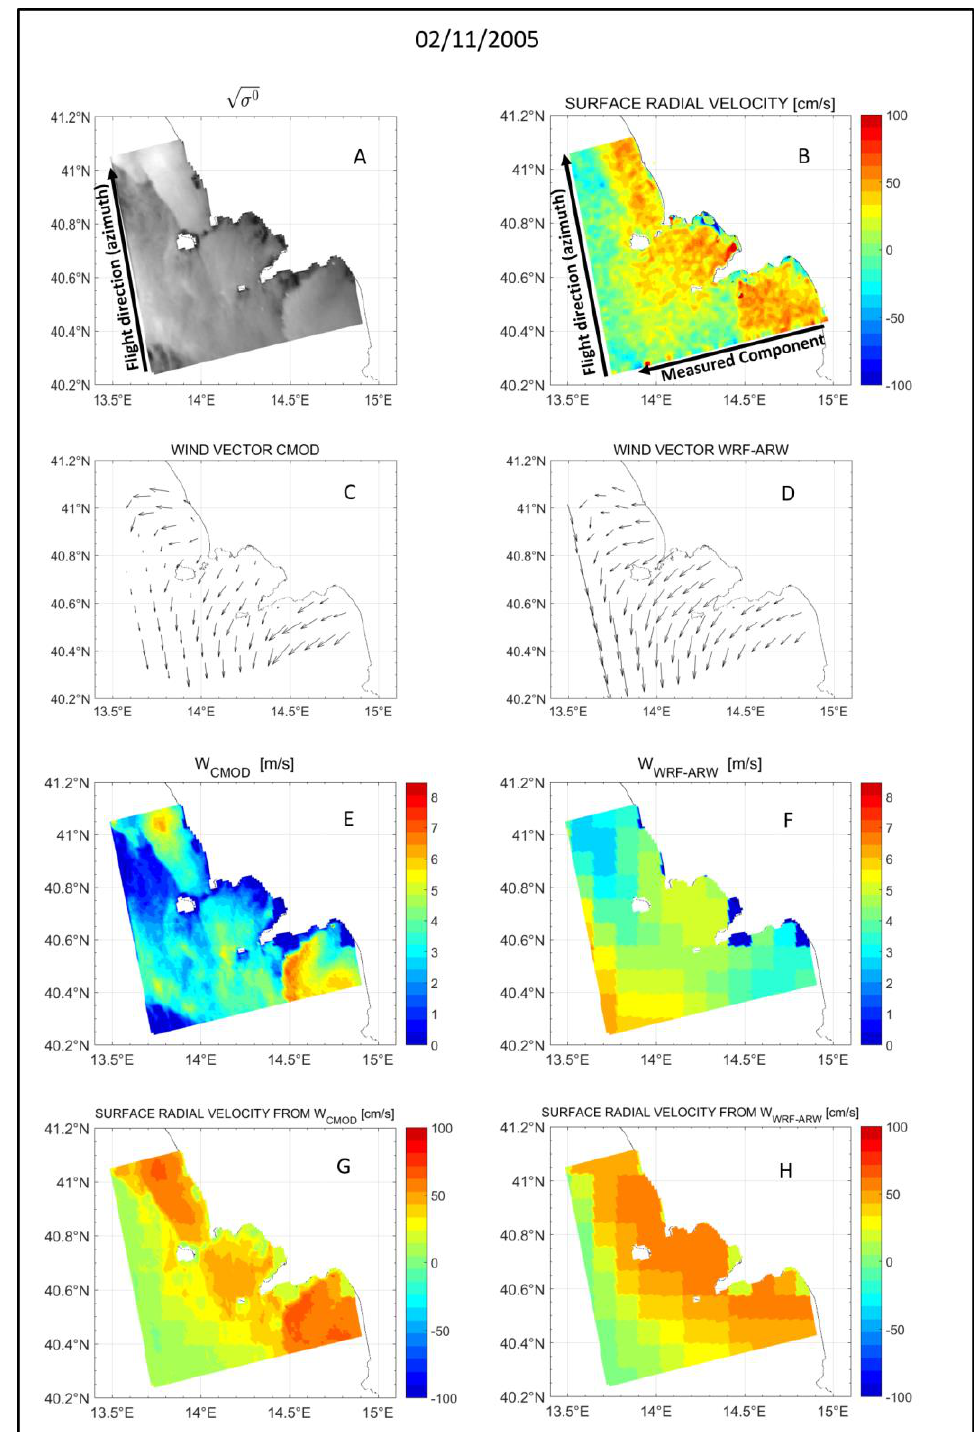
Figure 8. Results related to the acquisition of 02/11/2005. The image is divided as follow: ( A ) is the 𝜎 0 ; ( B ) is the estimated Doppler Anomaly maps of the marine area converted into the line-of-sight component of the sea surface velocity; ( C ) is the wind direction obtained from the CMOD model; ( D ) is the wind direction obtained from the WRF-ARW model; ( E ) is the wind speed relative to the CMOD model; ( F ) is the wind speed relative to the WRF-ARW model; ( G ) and ( H ) is the surface radial velocity due to the wind component, evaluated as descried in section 4, for the CMOD model and for the WRF-ARW model, respectively.